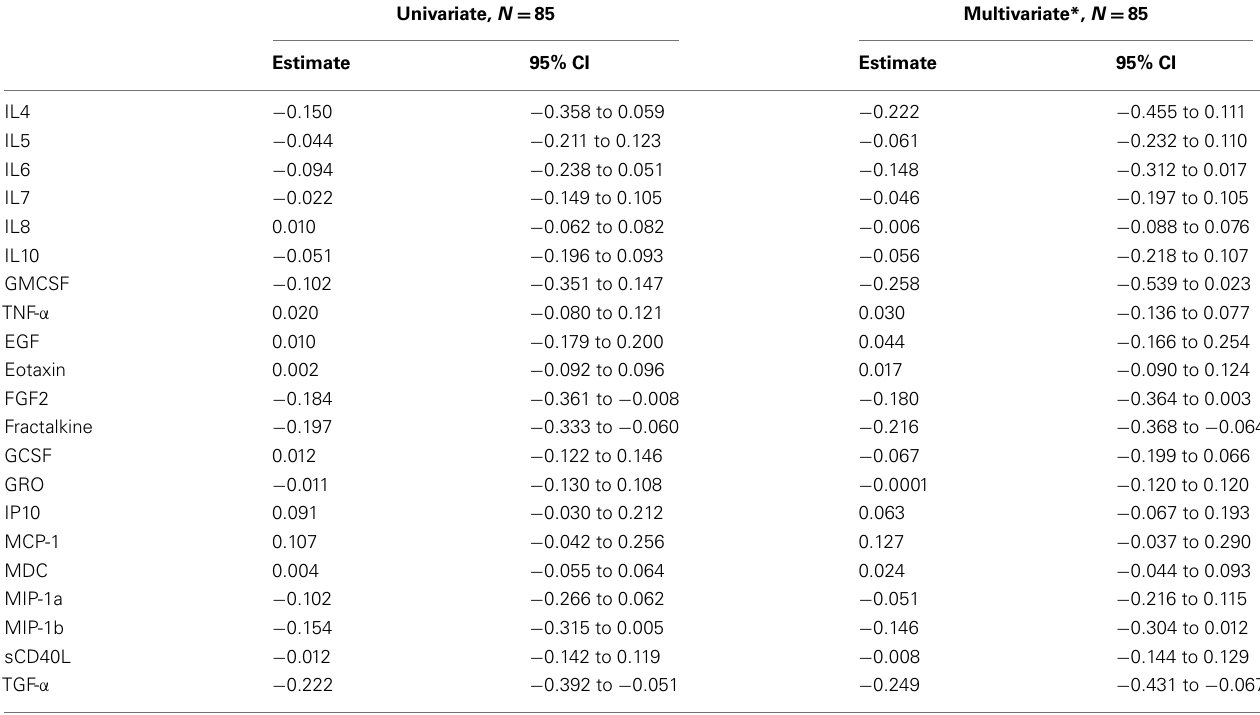
Table 3 | Dose–effect relationships between ln-transformed cytokines measurements and ln-transformedTCDD current concentrations. Univariate, N =